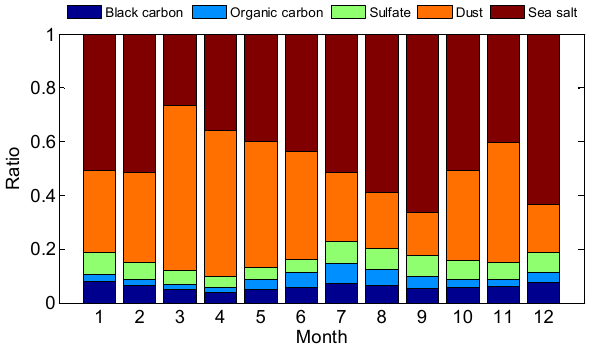
Figure 5. Monthly-averaged climatological aerosol composition (as percentages of total optical depth averaged over the 15 H 2 O absorp- tion bands) for the five composite MERRA aerosols (black carbon, organic carbon, sulfate, dust, and sea salt) in the daytime (13:00LT).